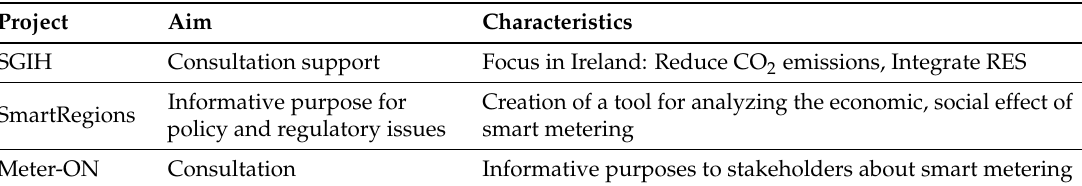
Table 10. Summary of consultation projects.